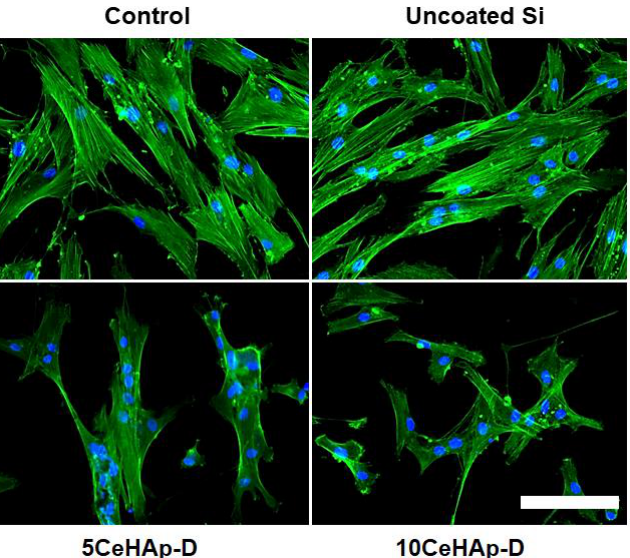
Figure 13. Actin cytoskeleton organization of gingival fibroblasts after 24 h of incubation with uncoated Si substrates and different dextran coated cerium doped hydroxyapatite coatings (5CeHAp- D and 10CeHAp-D). F-actin (green) was labeled with phalloidin-phalloidin-fluorescein isothiocyanate (FITC) and nuclei (blue) were counterstained with 4 ′ ,6-diamidino-2-phenylindole dihydrochloride (DAPI). Scale bar: 20 µm.